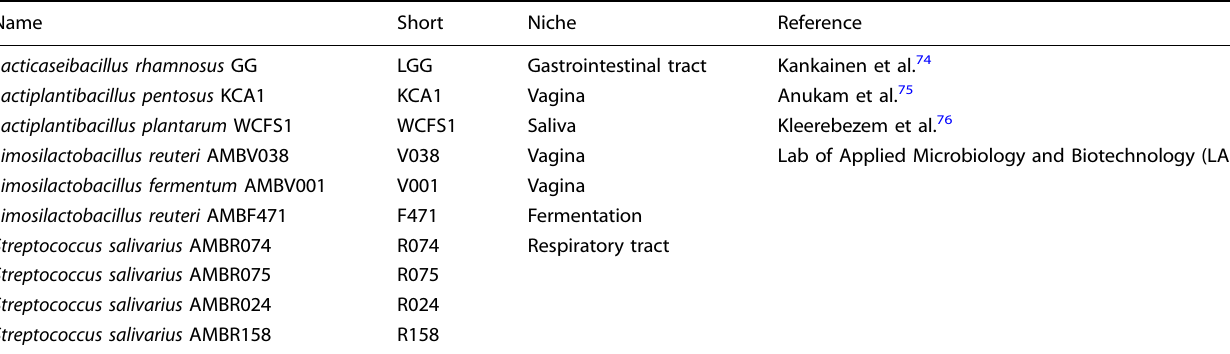
Table 3. Probiotic